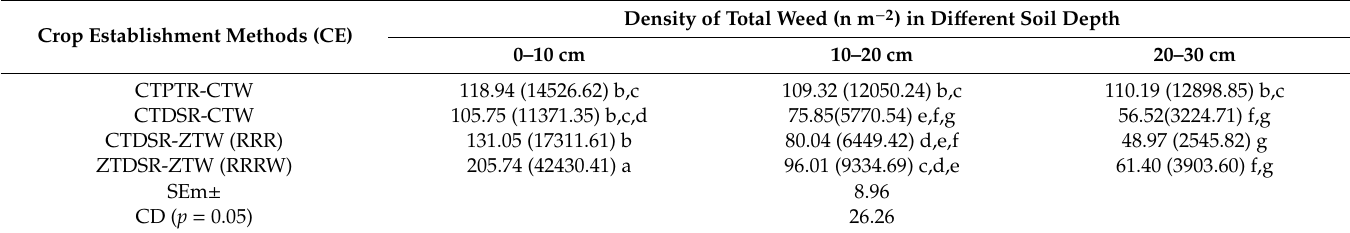
Table 6. E ff ects of crop establishment methods and soil depth on the total weed seed bank. Crop Establishment Methods